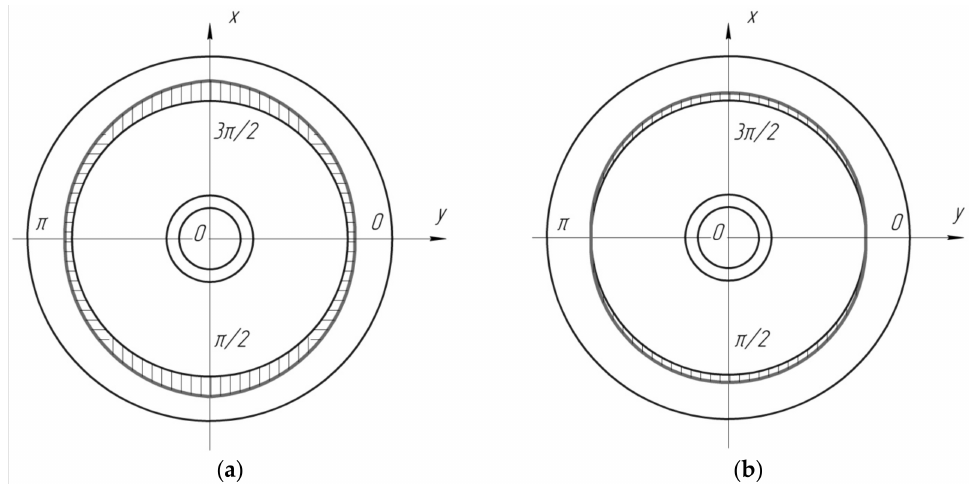
Figure 1. Diagrams of wear of the CBRTB after interaction with the center plate of the body: ( a ) In all directions; and ( b ) in two